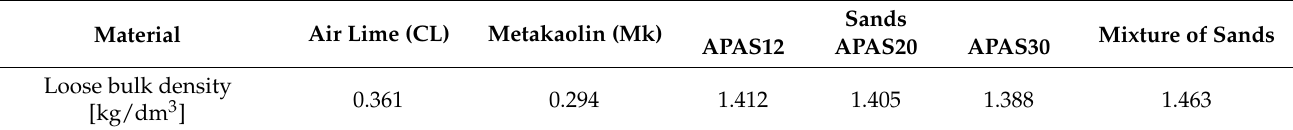
Table 2. Loose bulk density of mortars dry materials.